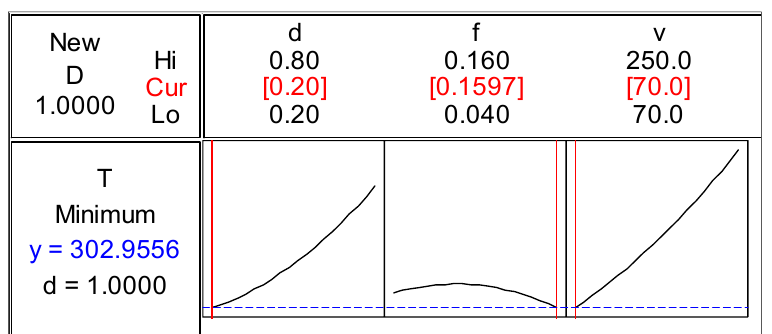
Fig. 6. Optimization of cutting temperature by desirability